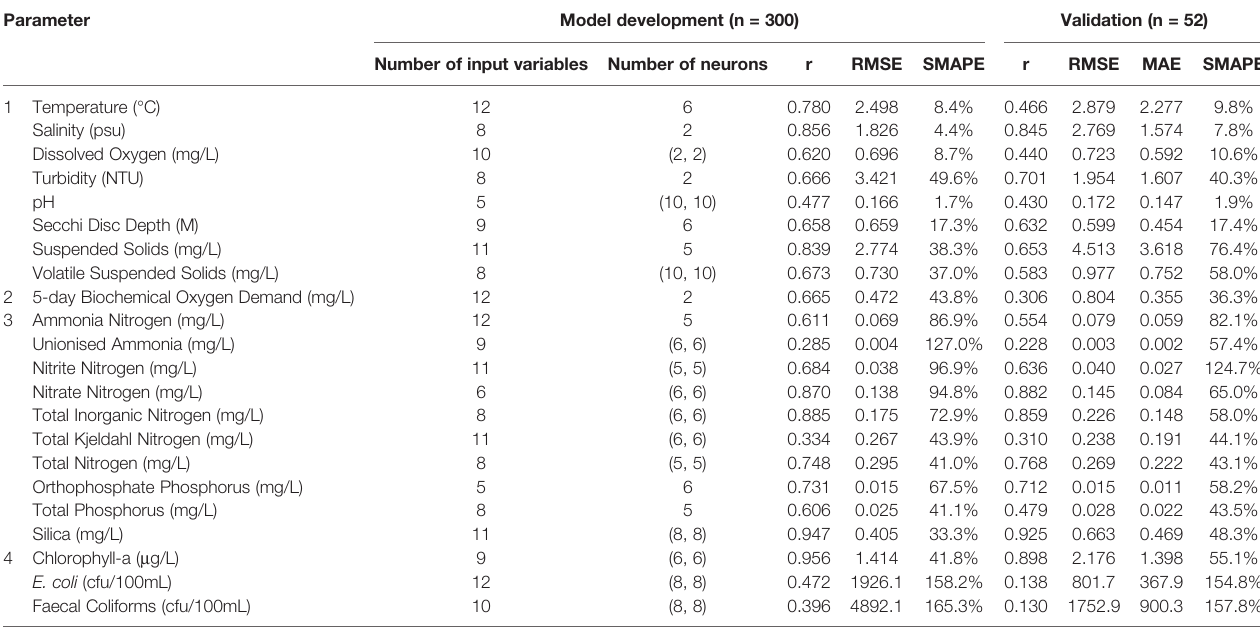
TABLE 4 | Modeling results of the 22 water quality parameters calculated using arti fi cial neural networks (ANN) on both training and validation datasets. Parameter Model development (n = 300) Validation (n = 52) Number of input variables Number of neurons r RMSE SMAPE r RMSE MAE SMAPE 1 Temperature